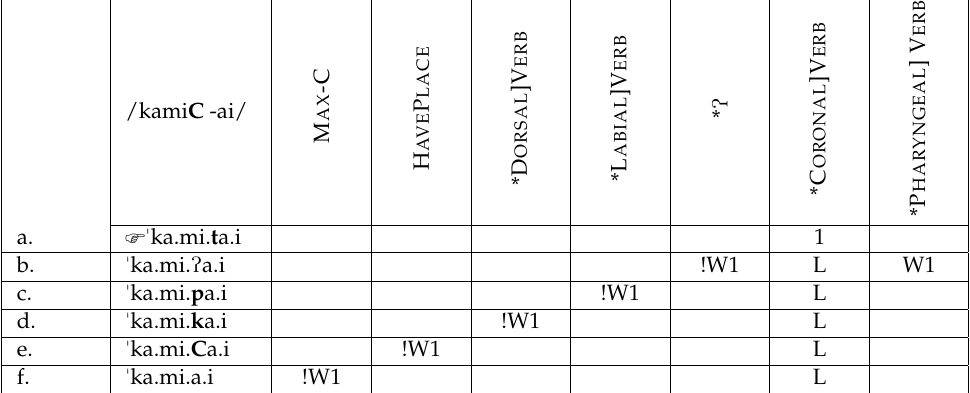
Table 4. /kap ɨ C -aN/ → [ ˈ ka.p ɨ . p ãN] ‘alligator’